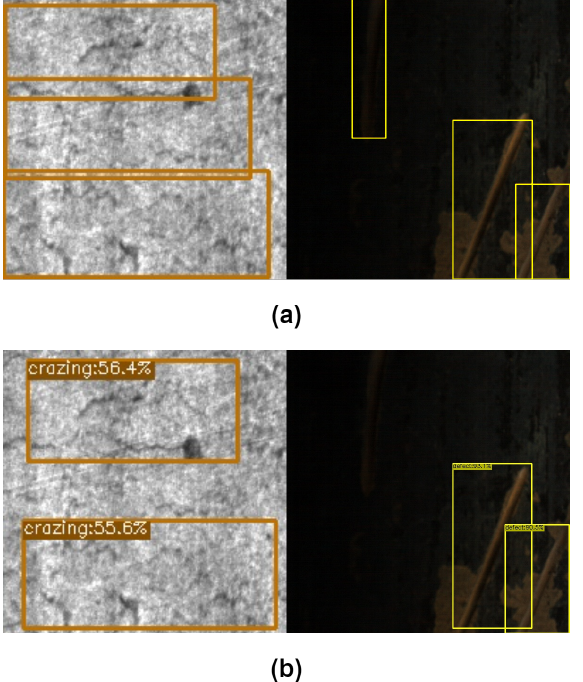
Figure 11. The failure case results. ( a ) Ground truth of the dataset. ( b ) Model prediction failure cases of this